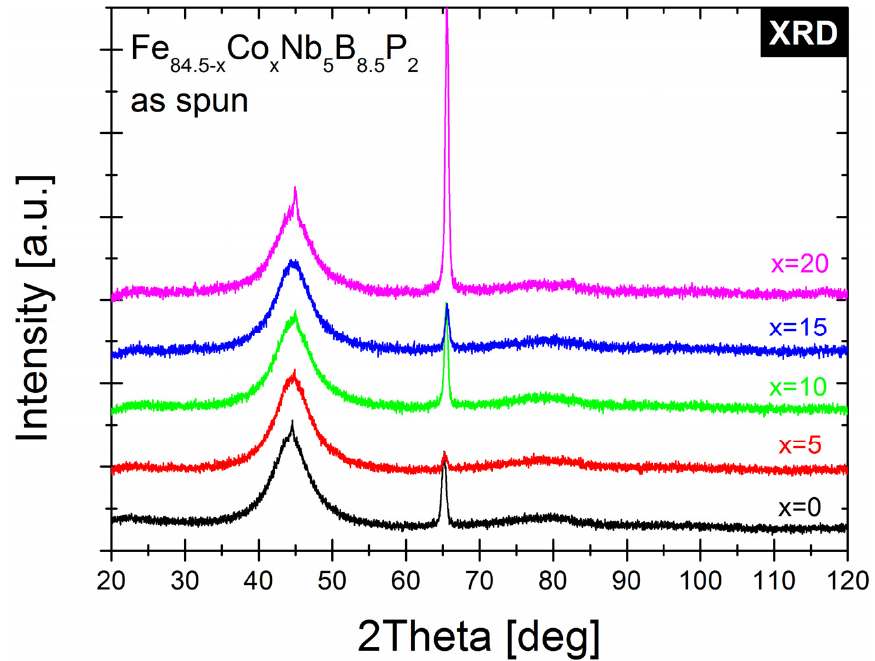
Figure 4. The X-ray diffraction patterns of Fe 84.5 − x Co x Nb 5 B 8.5 P 2 ribbons in as-spun state.